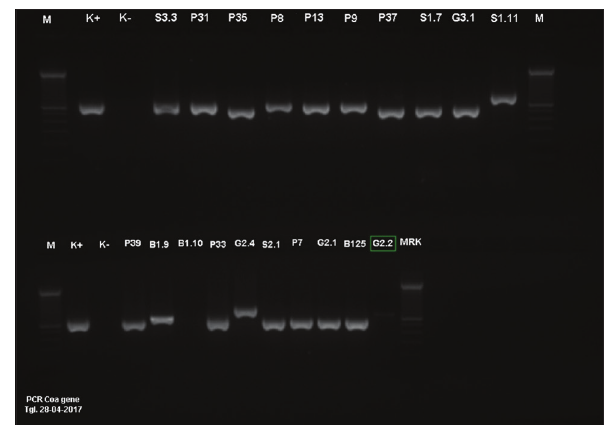
Figure-1: Agarose gel electrophoresis of Staphylococcus aureus polymerase chain